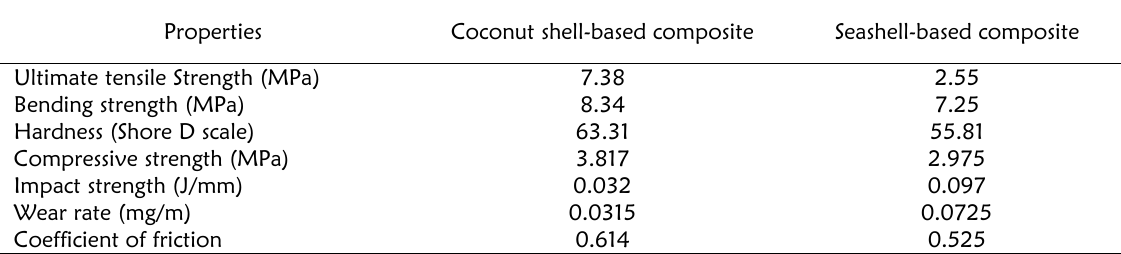
Table 7: Experimental